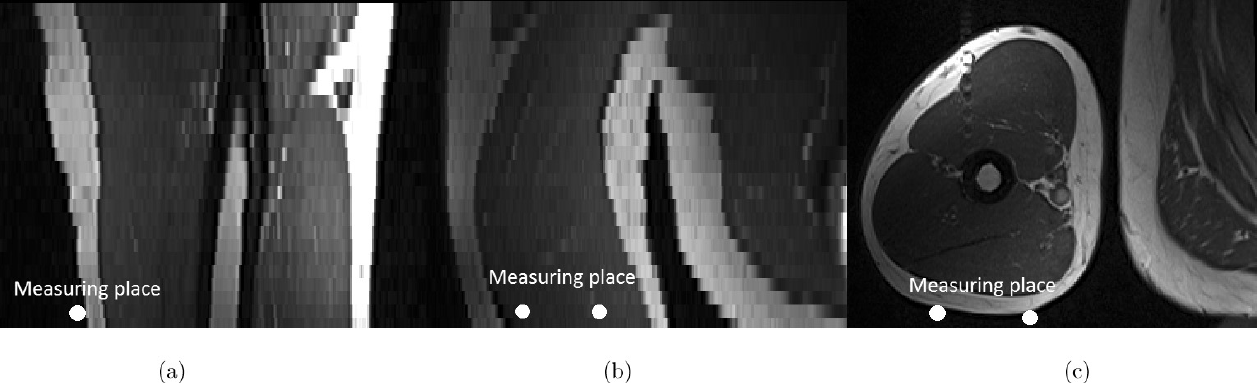
Fig. 2. Anatomical image of the arm of Subject 4. The measuring place was on the right biceps brachii, illustrated with white circles in the anatomical image in (a) sagittal (b) coronal and (c) axial slices. An important challenge for sEMG and NIRS is the fact that soft tissue (mostly fat), shown in white color, intervenes with the signal, especially when the active muscle is 10 mm or more below skin surface. 1